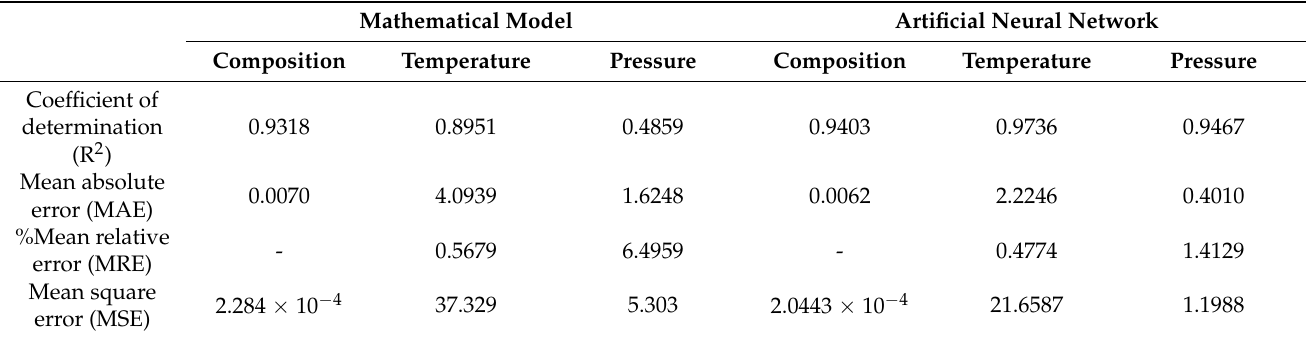
Figure 8. Comparison between the real and predicted pressure: ( a ) mathematical model, and ( b ) artificial neural network. Table 6. Summary of the estimated errors.